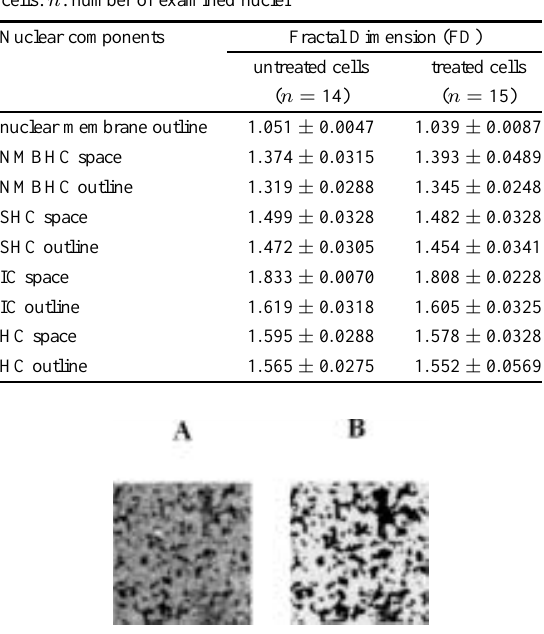
Fractal dimension (FD) of nuclear components segmented by grey level threshold method. IC: inter(eu)chromatin; HC: total nuclear heterochromatin; NMBHC: nuclear membrane-bound heterochro- matin; SCH: nuclear scattered heterochromatin. Cell treatment: